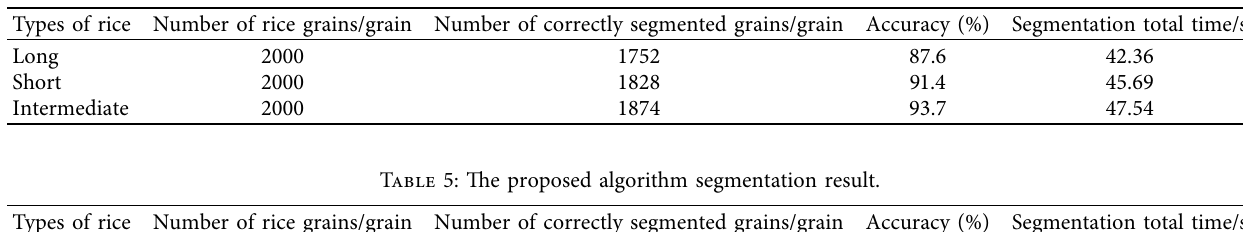
Table 4: Fully convolutional neural network segmentation result.